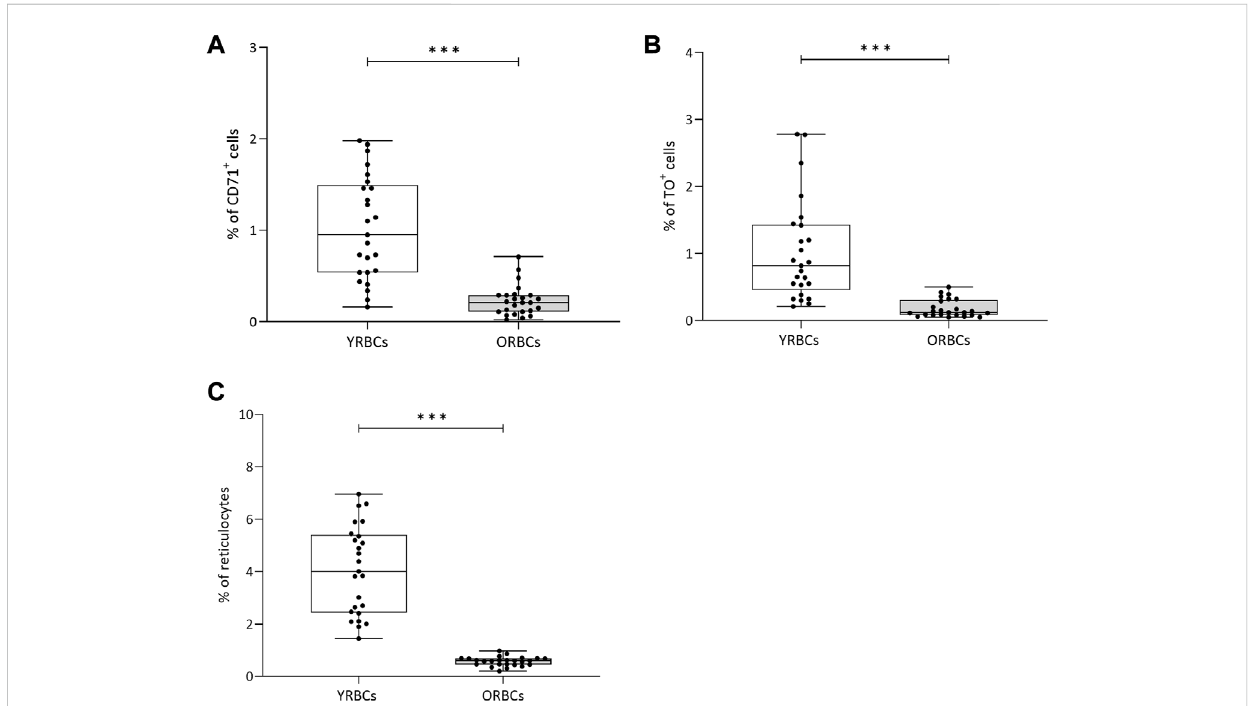
FIGURE 1 Percentage of reticulocytesafter Percollfractionation. Percentages of (A) CD71 + cells and (B) TO+ (Thiozole orange) cells were assessed using fl ow cytometry. (C) Percentageofreticulocytescellswasassessedusingahematologyanalyzer.YRBCsreferstoyoungredbloodcells,andORBCsrefertoold red blood cells. * denotes a signi fi cant difference between groups (* p < 0.05, ** p < 0.01, *** p < 0.001). Blood samples were collected from healthy volunteers ( n = 25).